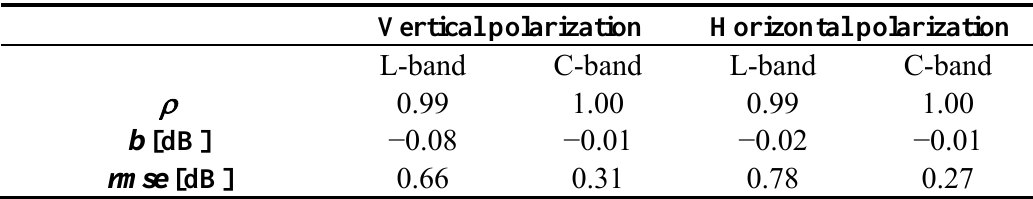
Table 4. Comparison between IEMM- and NN-derived  0 in terms of correlation coefficient  , bias error b and root mean square error rmse .